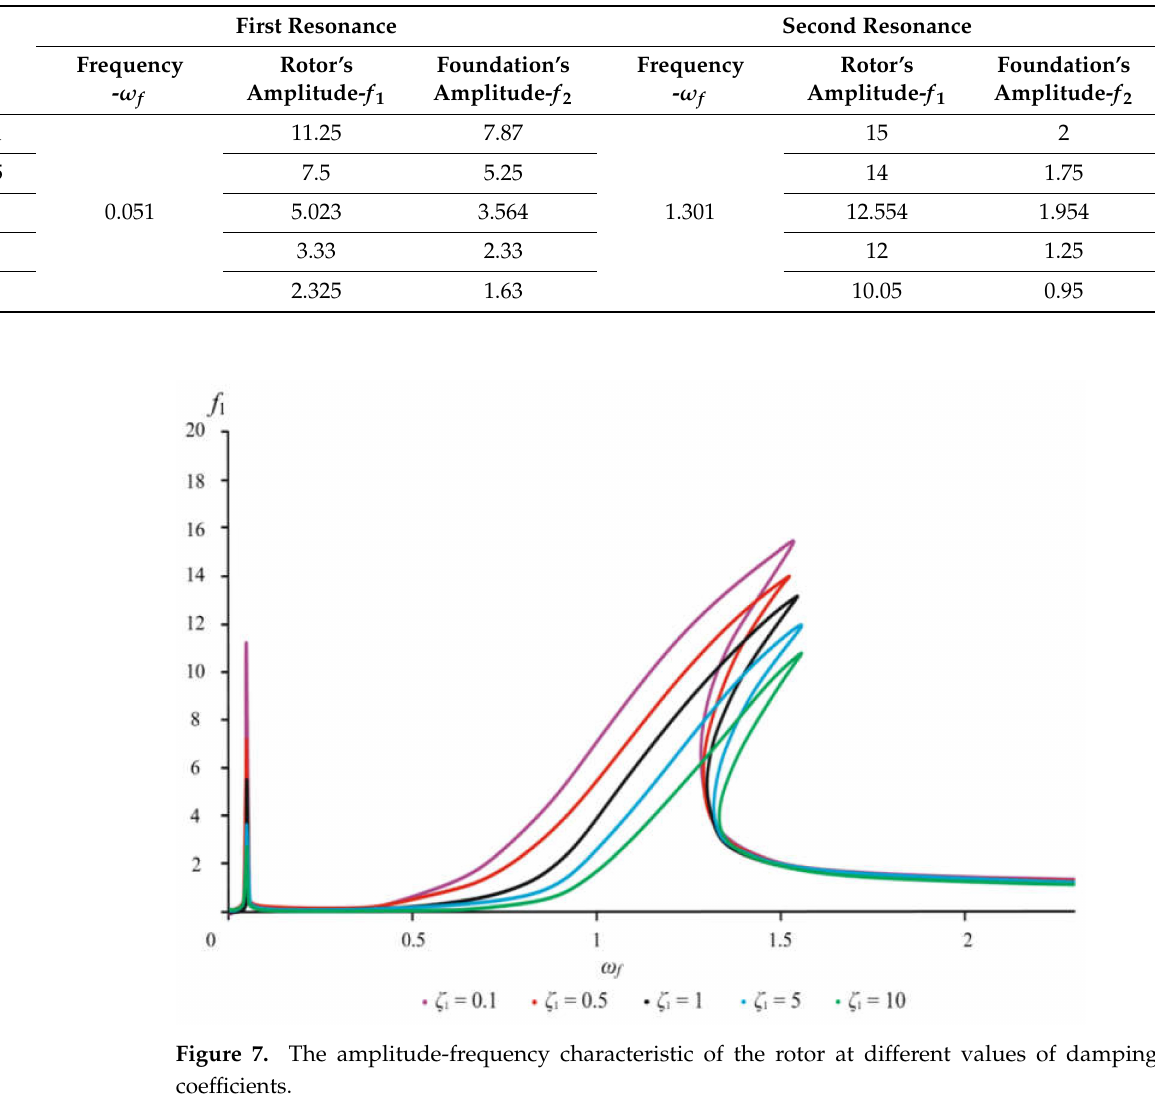
Table 4. Amplitudes and resonant frequencies for different values of the damping coefficient.